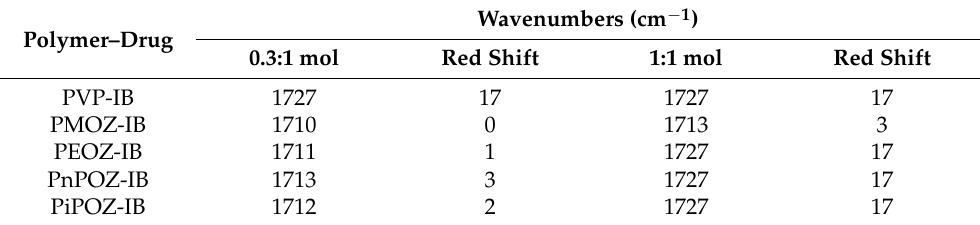
Table 1. The red shift of the carbonyl stretching mode from the carboxylic acid of IB at 1710 cm − 1 in (polymer)/(IB) = 0.3 mol and 1:1 mol solid dispersions. Wavenumbers (cm − 1 Polymer–Drug